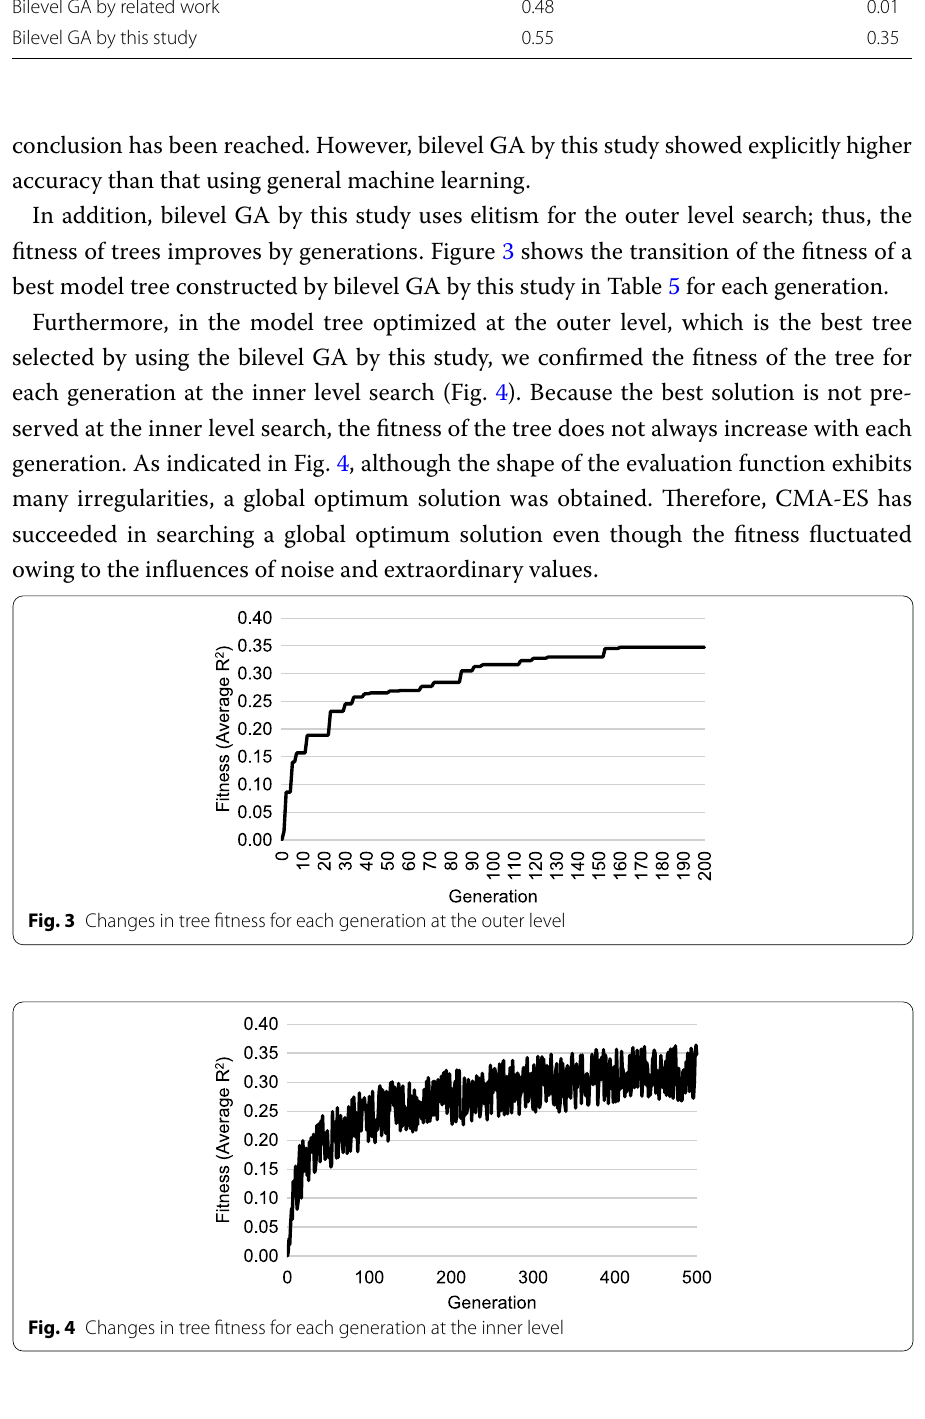
Table 5 Accuracy comparison using financial time series data Linear regression 0.49